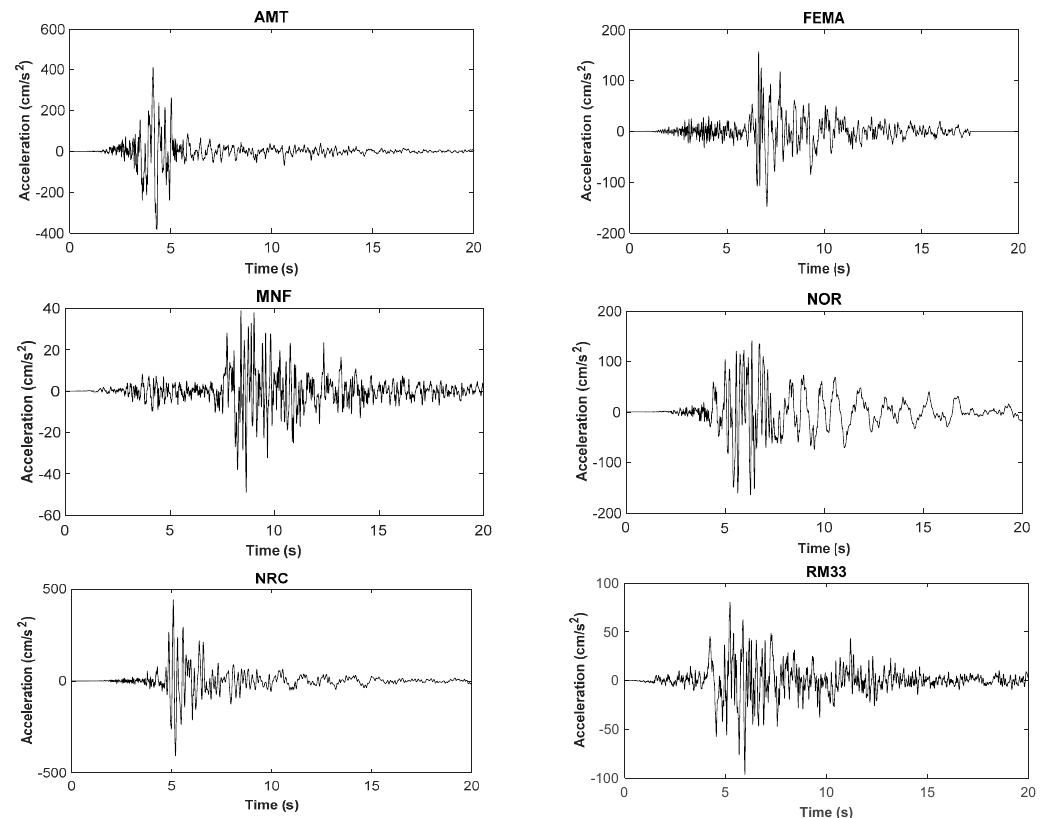
Figure 3. Fault normal components of the acceleration time series of the selected near-fault ground motion records.